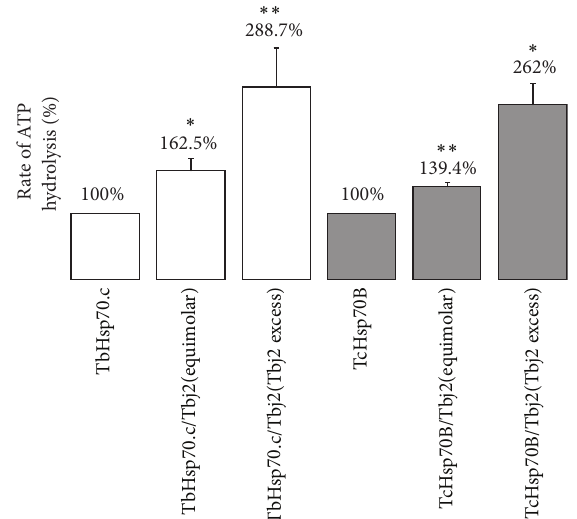
Figure 5: Stimulation of TbHsp70.c and TcHsp70B ATPase activity by co-chaperone Tbj2. The ATPase activity of TbHsp70.c (0.4 𝜇 M) and TcHsp70B (0.4 𝜇 M) was assayed in the absence and presence of Tbj2atequimolarconcentrations.Tbj2wasassayedina2-foldmolar excesstoTbHsp70.c(1 𝜇 M)andTcHsp70B(1 𝜇 M).Theunstimulated ATPase activity of TbHsp70.c and TcHsp70B isrepresented by 100%. The concentration of ATP, present in all reactions, was maintained at 600 𝜇 M. The data points were determined from triplicate ATPase activity measurements for three independent batches of purified protein and the data shown represents that of a typical experiment. The bars represent standard deviations. ∗ 𝑃 < 0.01 and ∗∗ 𝑃 < 0.05 .